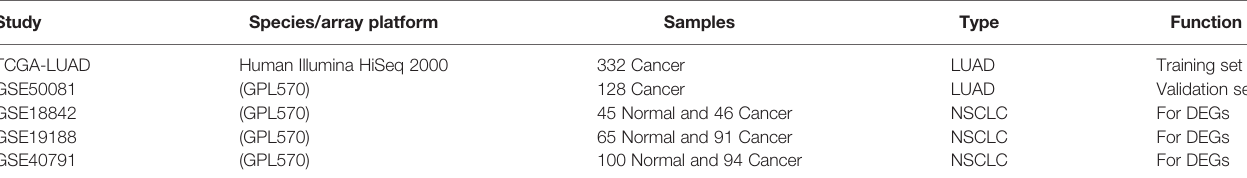
TABLE 1 | Characteristics of the public microarray datasets used in this study.